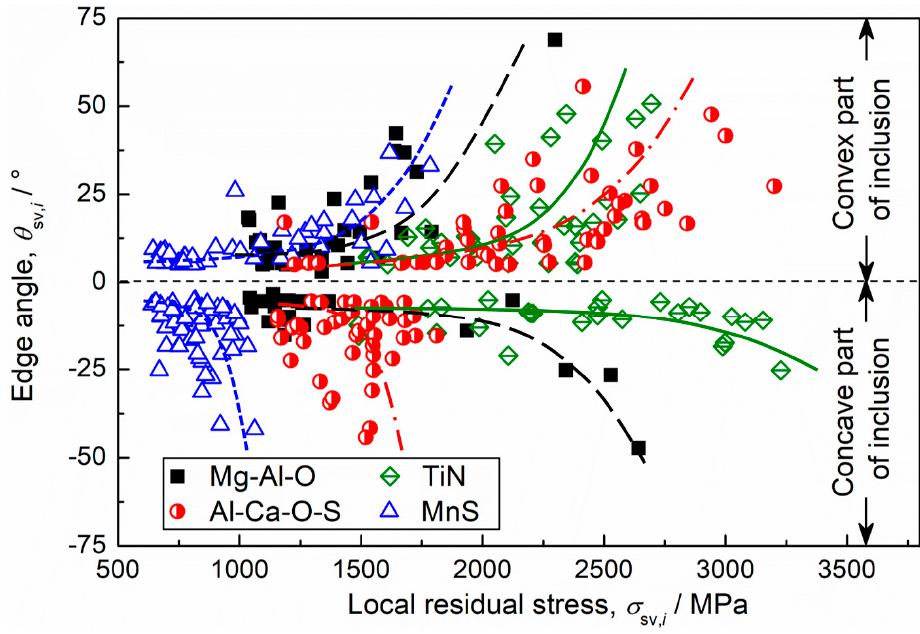
Figure 8. Relation between edge angle θ sv , i and local residual stress σ sv, i for different inclusions.